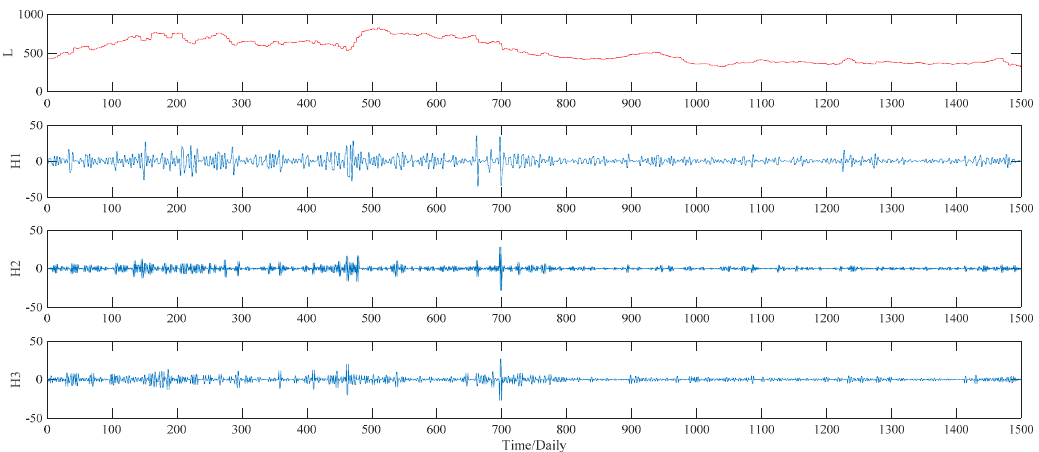
Figure 14. Decomposition results of the WPT method (corn). Algorithms 2017 , 10 , 108